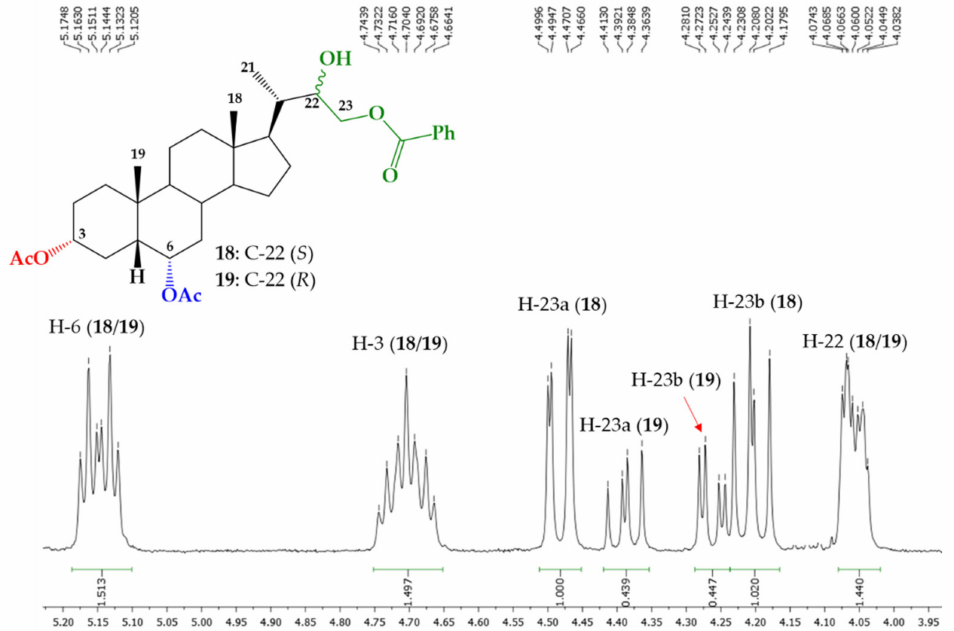
Figure 4. Amplification of 1H NMR spectrum of mixture 18 / 19 in the zone 3.95–5.20